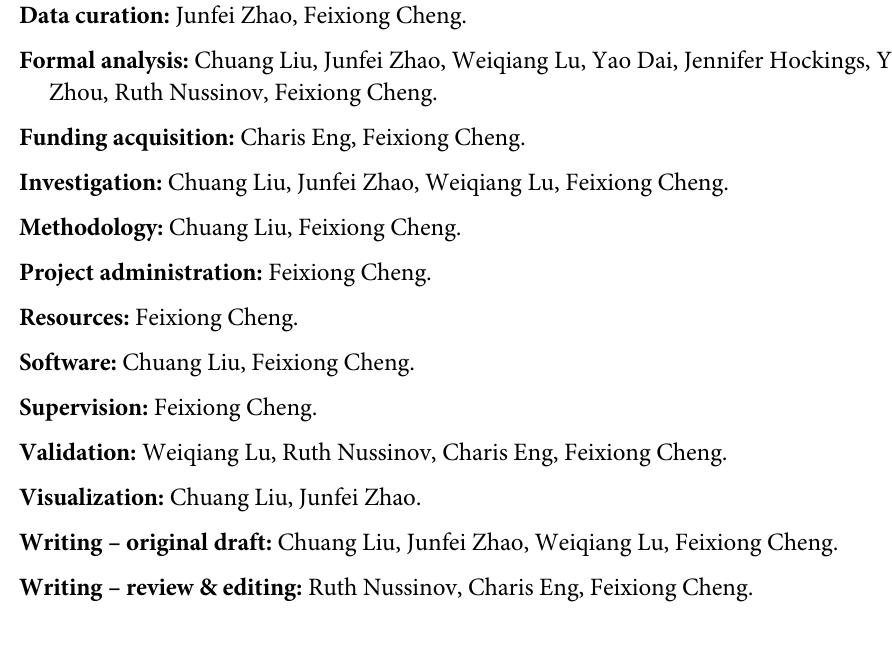
S4 Table. The final genetic interactions networks for 14 cancer types identified by Individ- ualized Network-based Co-Mutation (INCM) analysis. S5 Table. The detailed lists of five functional gene sets: Significantly mutated genes (SMGs), Cancer Gene Census (CGC), DNA damage repair (DDR) genes, Chromatin regu- lation factors (CRFs), and human essential genes. S6 Table. Average cum C value for five functional gene sets. The P values are calculated by the Wilcoxon rank-sum test over the corresponding gene set and human essential genes iden- tified in cancer cell lines. S7 Table. The predicted association between the network-predicted putative genetic inter- actions and the drug responses (sensitivity/resistance) for multiple therapeutic agents using ANOVA. S8 Table. The list of therapeutic pathways for the INCM-predicted putative genetic inter- actions targeted by FDA-approved drugs using drug-target network